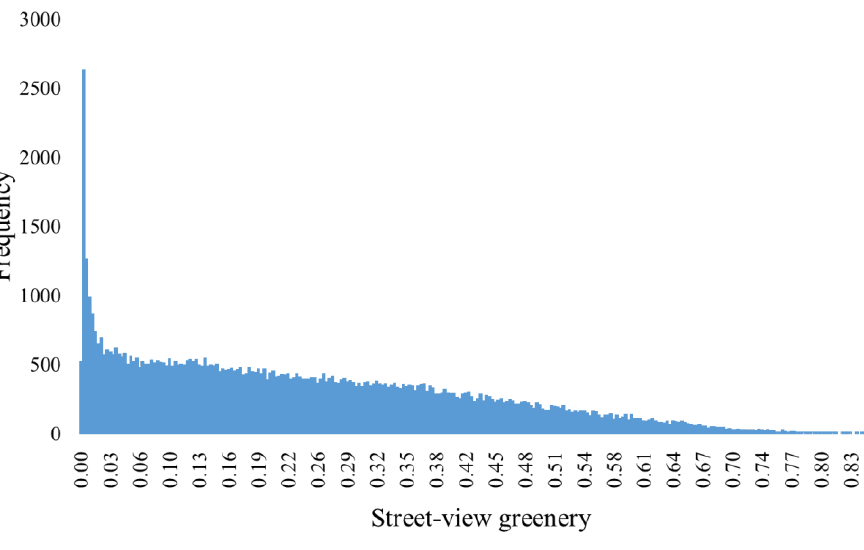
Figure 4. Histogram distribution of street-view greenery.